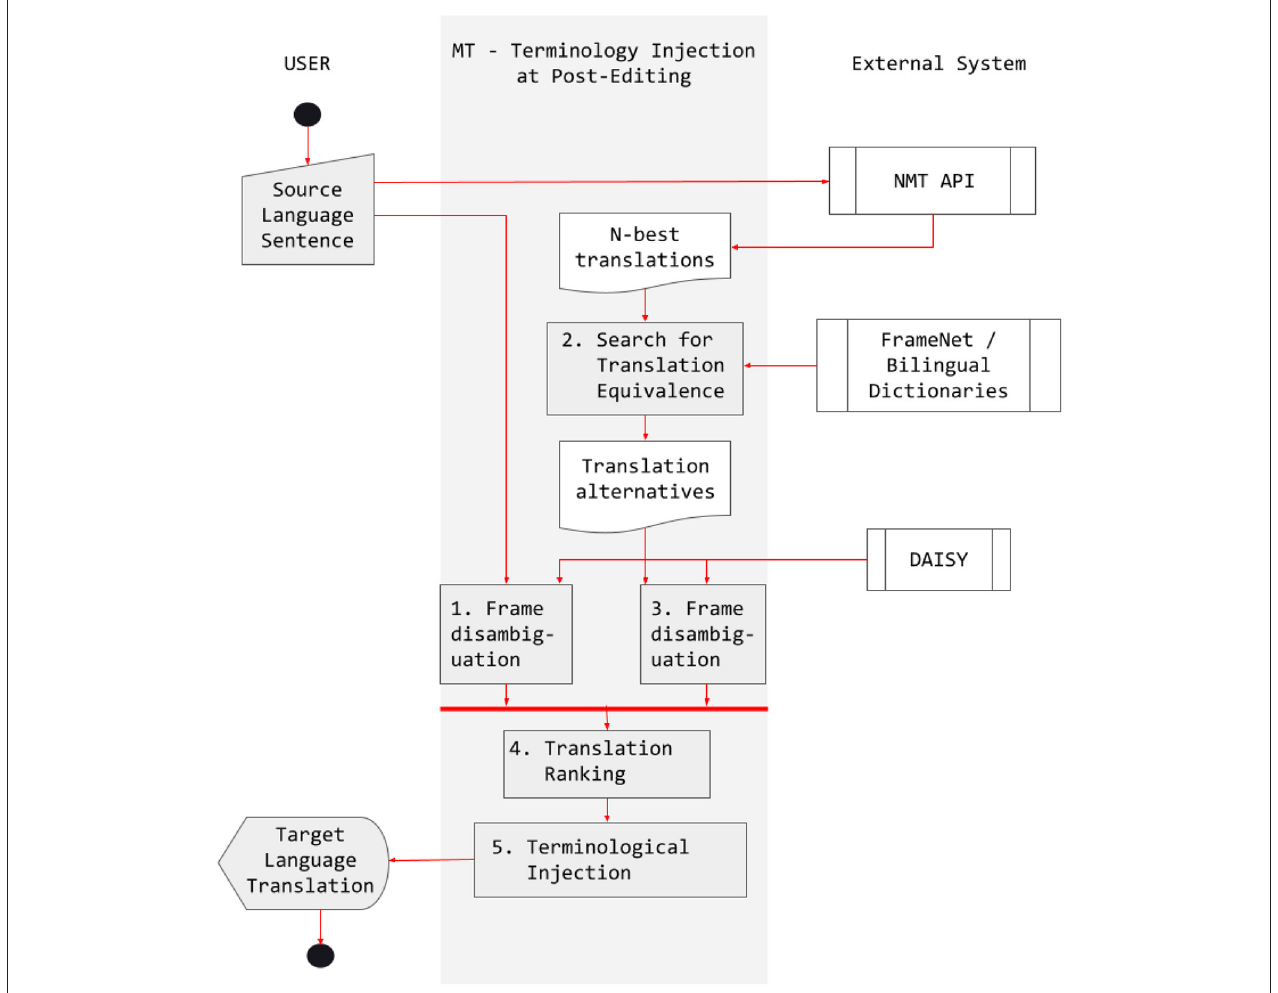
FIGURE 13 | The Scylla Pipeline. Reproduced with permission from Costa et al. (2022). (CC BY-NC-ND